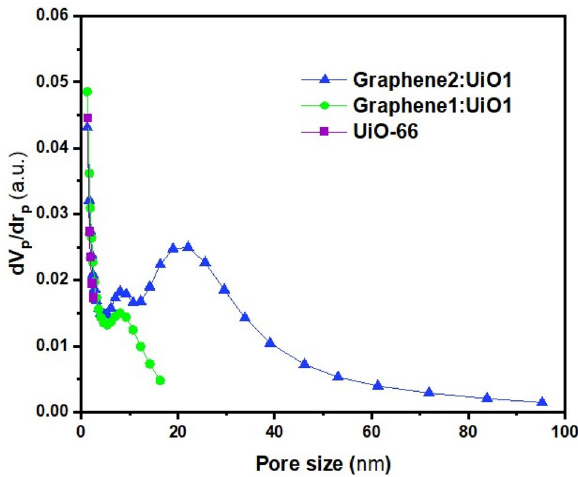
Figure 5. Pore size distributions of samples in this